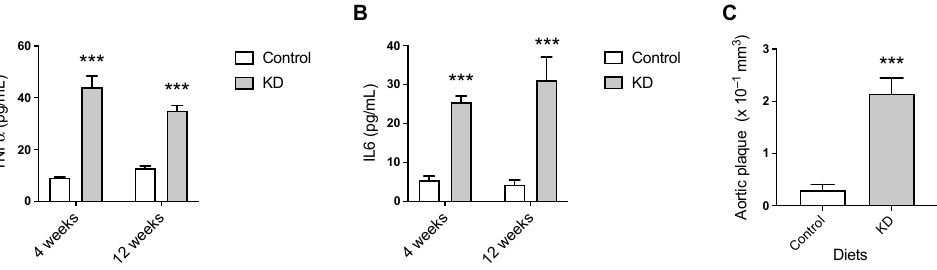
Figure 3. The effect of 12 weeks of KD on systemic inflammation and atherosclerotic plaque burden. Plasma concentrations of ( A ) interleukin 6 (IL-6) and ( B ) tumor necrosis factor α (TNF- α ). ( C ) Ex vivo 14T-MRI volumetric assessment of total atheroma. Data shown are the mean ± SEM, n = 4–8/group. ***, p < 0.001, KD versus control.